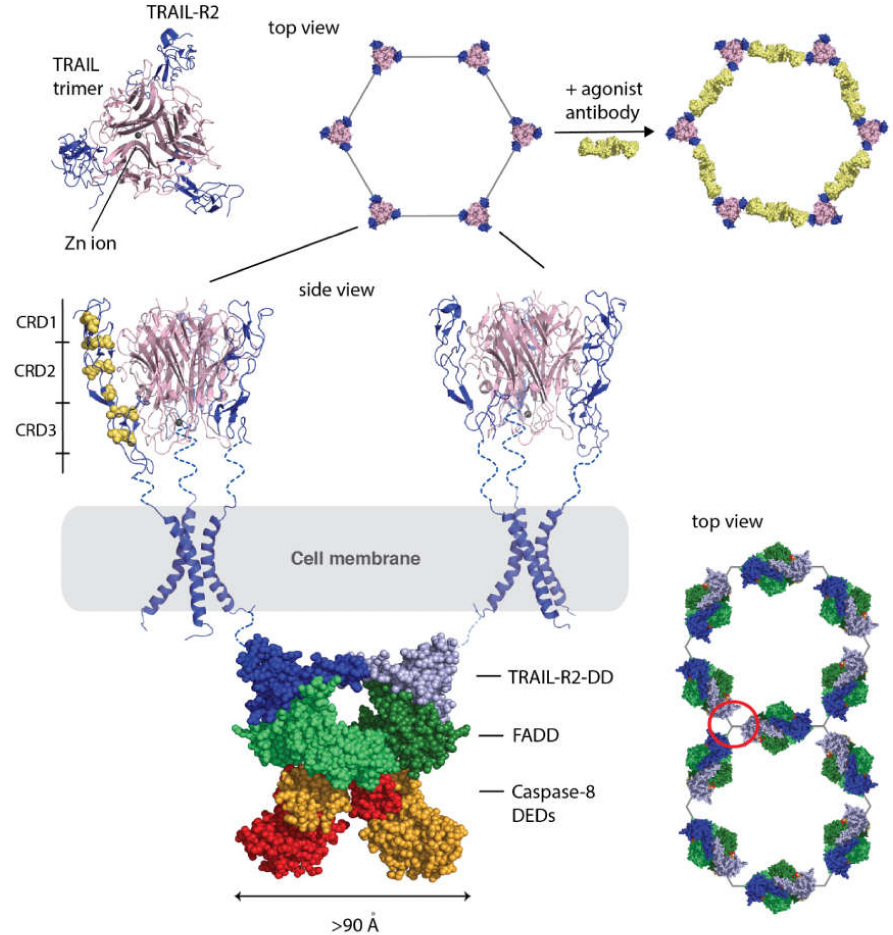
Figure 2. TRAIL-R2 activation and formation of the death inducing signaling complex (DISC). The TRAIL-TRAIL-R2 complex structure (PDB ID: 1DU3) is shown in cartoon representation (top left). The TRAIL ligand trimer (pink) surrounded by three TRAIL-R2 receptors (blue). These complexes can cluster on the cell surface in a hexagonal lattice (top middle) that are stabilized by agonist antibodies shown in yellow (top right). Below two TRAIL-TRAIl-R2 complexes are illustrated in side view. The three cysteine-rich domains (CRD1-3) of TRAIL-R2 are labelled in the left complex. The transmembrane domain of TRAIL-R2 is also shown (PDB ID: 6NHY). A model of the DISC complex is illustrated below the cell membrane in spheres representation. The partial model of the TRAIL death domain (TRAIL-DD) dimer is shown in dark and light blue, the Fas associated domain (FADD) dimer is shown in dark and lighter green, and the Caspase 8 death effector domain (DED) dimer is shown in red and orange. On the right a model of how the DISC may arrange in a hexagonal lattice is illustrated in top